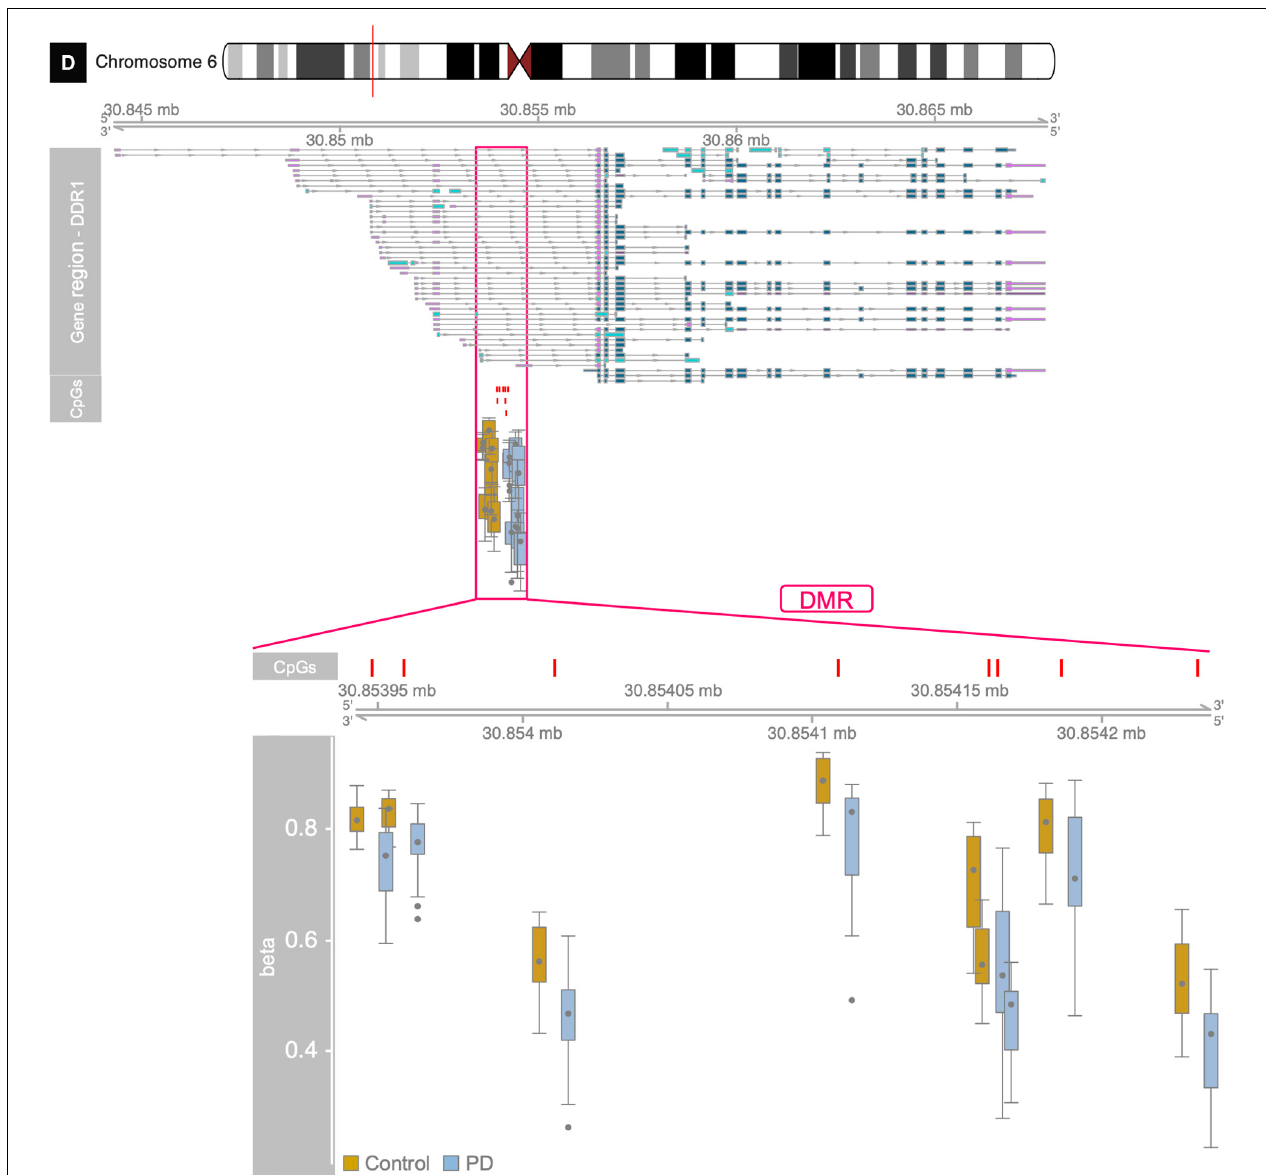
FIGURE 2 | Differentially methylated regions nearest to the following genes: (A) NFYA , (B) VTRNA2-1 , (C) CYP1A1 , and (D) DDR1 .